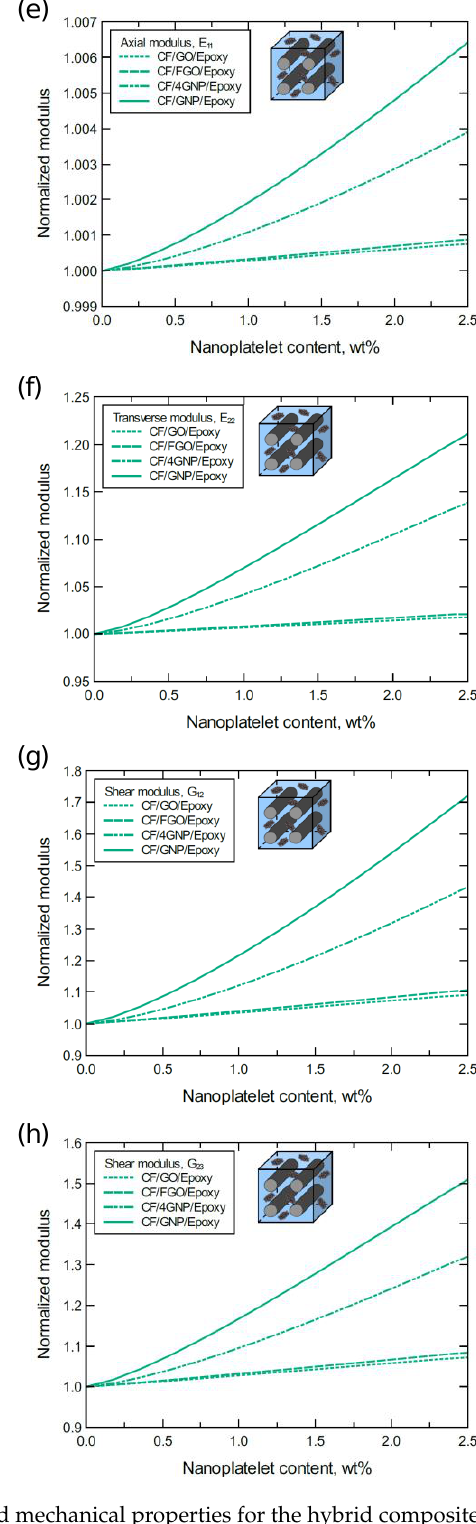
Figure 11. The reinforcing effect of nanoplatelets on the predicted mechanical properties for the hybrid composites ( a – d ) at 1.0 wt% nanoplatelet content for various aspect ratio values, ( e – h) at 10 3 aspect ratio for various nanoplatelet contents. The volume fraction of CF is 56%.